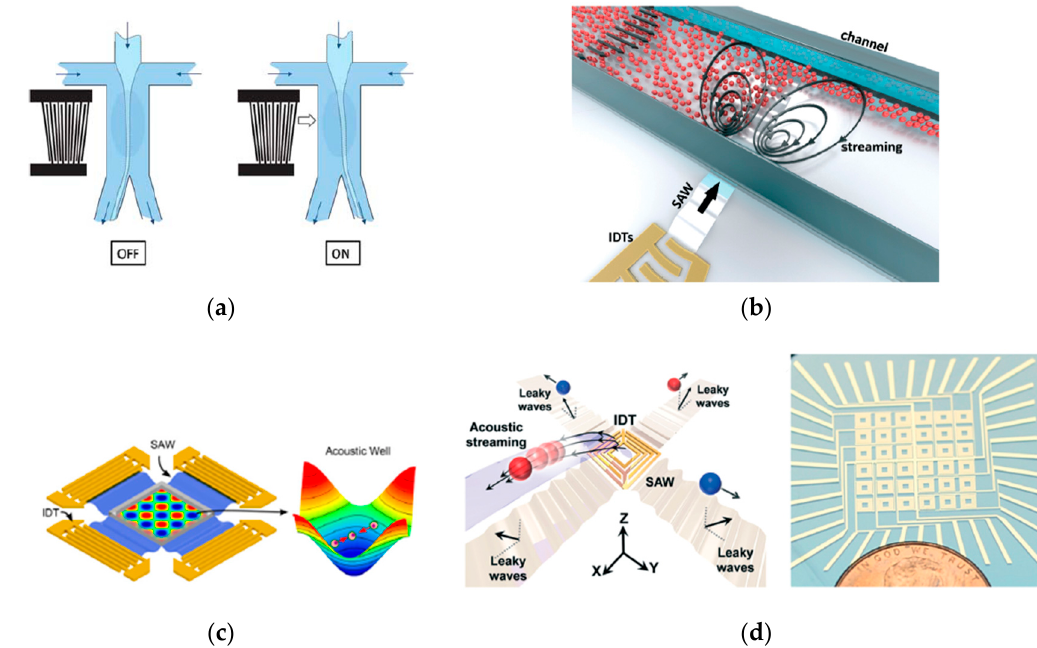
Figure 2. Typical in-plane manipulating devices proposed by ( a ) Franke et al. [16], which represents manipulation in R p (cid:28) λ conditions; (Republished with permission of the Royal Society of Chemistry from reference [16]. Copyright © The Royal Society of Chemistry 2010; permission conveyed through Copyright Clearance Center, Inc.) ( b ) Collins et al. [45], using acoustic stream in plane, when the particles’ radii are similar to the wavelength size, the acoustic stream plays a vital part in the devices; and; (Republished with permission of the Royal Society of Chemistry from reference [45].